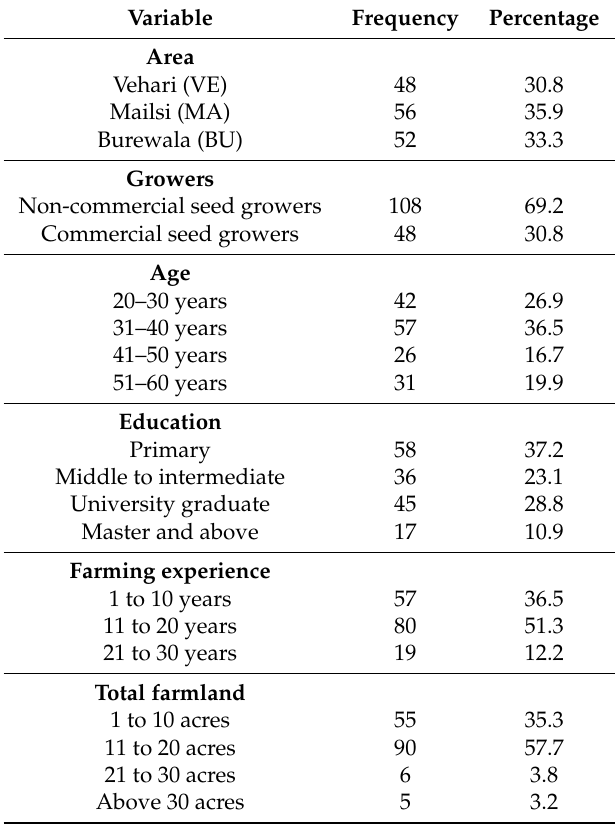
Table 1. Basic demographic profile of the farmers